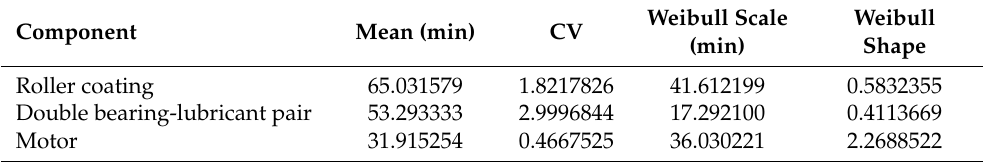
Table 16. Time to recover from roller coating (appeared as “roller and shaft” in the stop dataset), double bearing-lubricant pair (appeared as “bearing and mounting guide” in the stop dataset) and motor failures in the bleaching machine